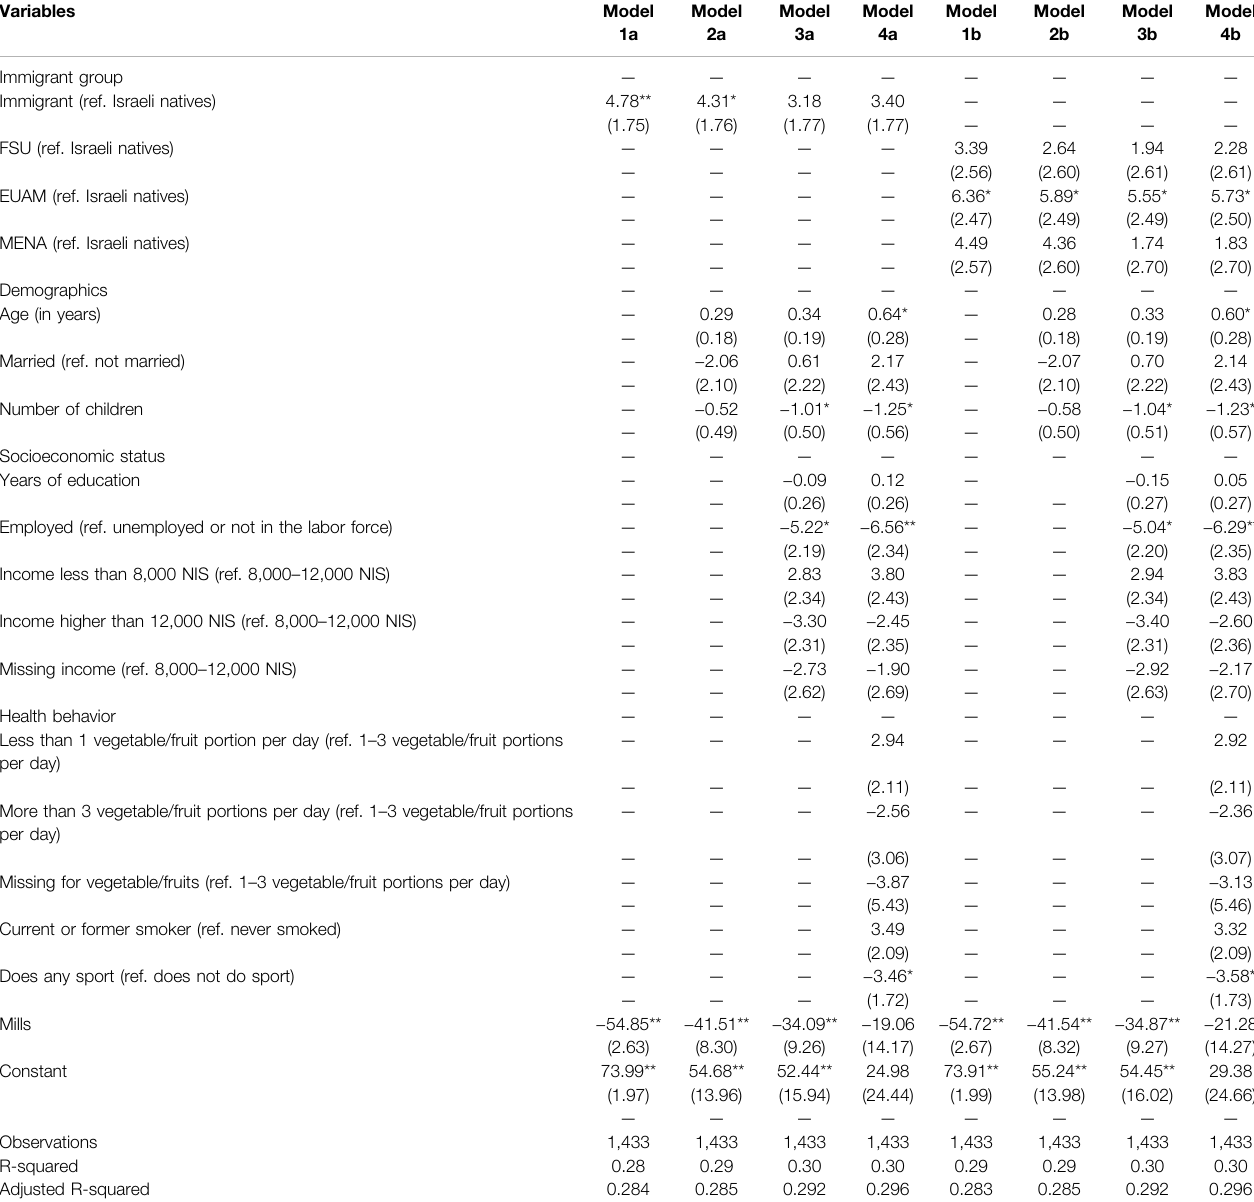
TABLE 3 | Coef fi cients (standard error) of OLS regression equations predicting severity illness index, Women. Variables